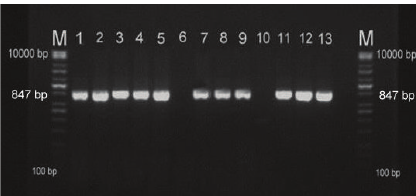
Figure 2: Skin wart samples. PCR products for E2, E5, and L2 genes visualized in an ethidium bromide-stained 1.5% agarose gel following electrophoresis in TBE buffer. M: 100–10,000 bp marker; lanes: 1–5, 7–9, and 11–13: BPV-1-positive samples with bands at 847 bp; lane 6: no sample; lane 10: negative